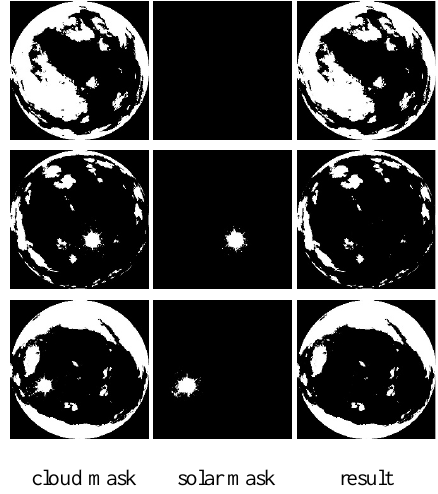
Figure 8. Removing the impact of direct sunlight.